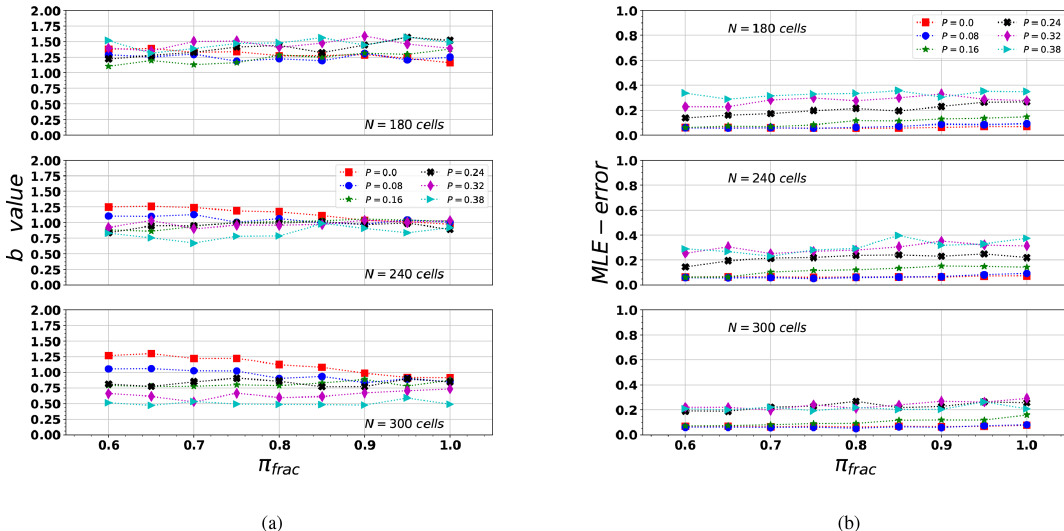
Figure 6. The (a) b value (Eq. A8) and (b) the b -value error (Eq. A9) computed for different synthetic series considering three input parameters ( N , P , π frac ). From top to bottom, N = 180, N = 240, and N = 300 (cells per lateral size in the domain).